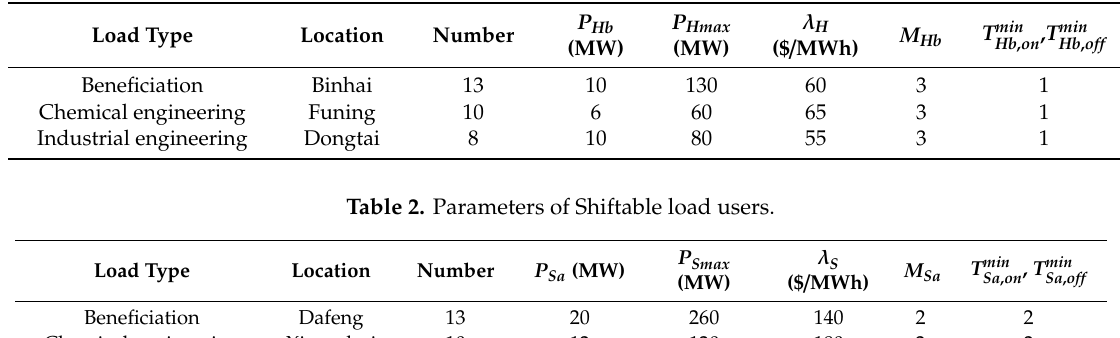
Table 2. Parameters of Shiftable load users.